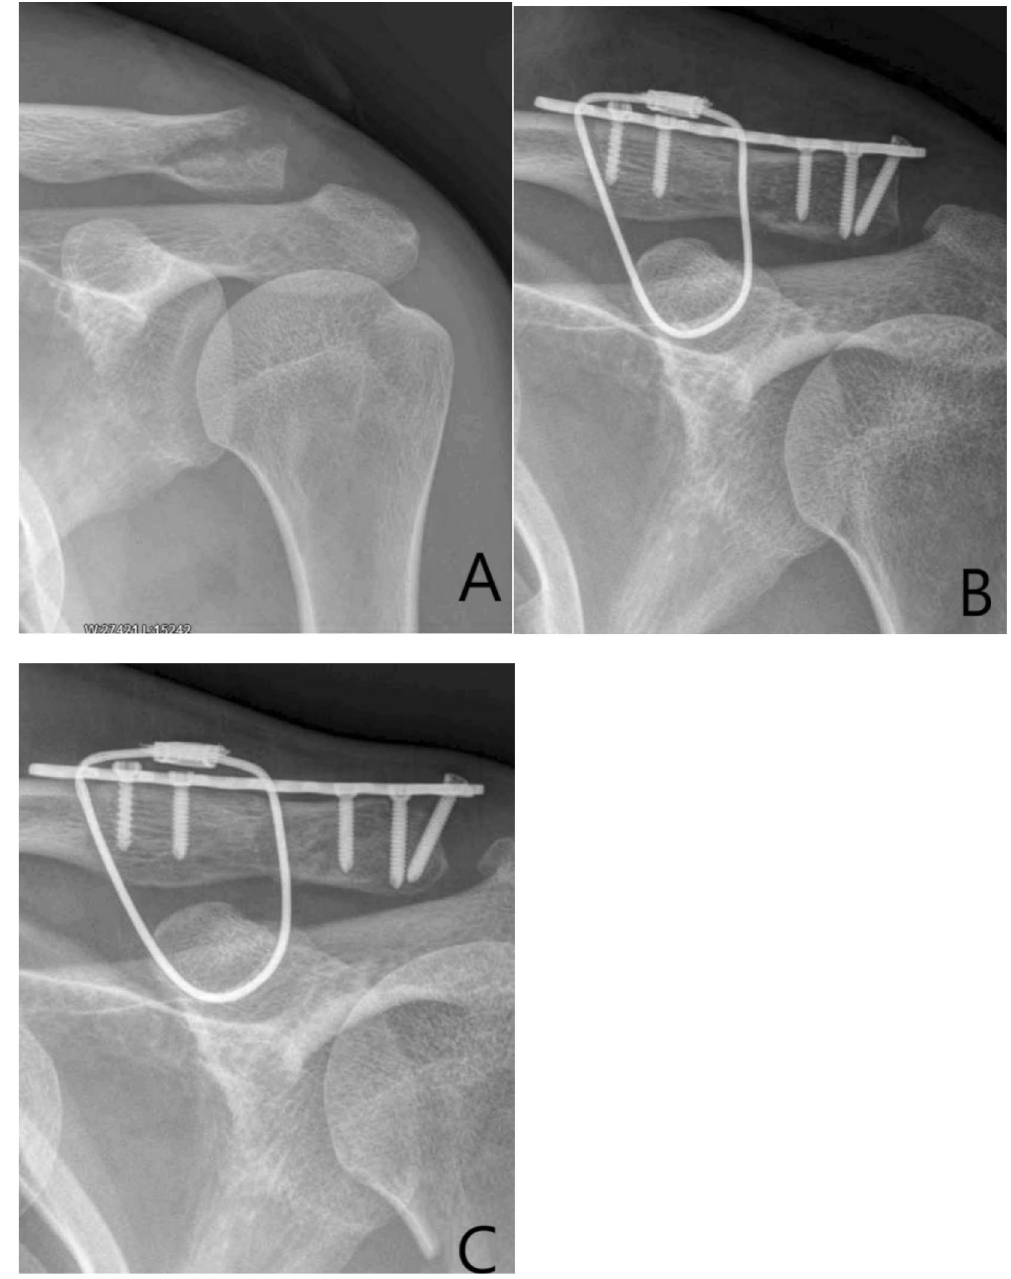
Figure 2. ( A – C ) A 36 years old woman with left distal clavicle fracture. The distal fragment less than 2.5 cm, a titanium cable was inserted and the metacarpal locking plate was fix. ( A ) Preoperative X-ray of the shoulder; ( B ) postoperative X-ray, ( C ) 3 months after surgery show fracture